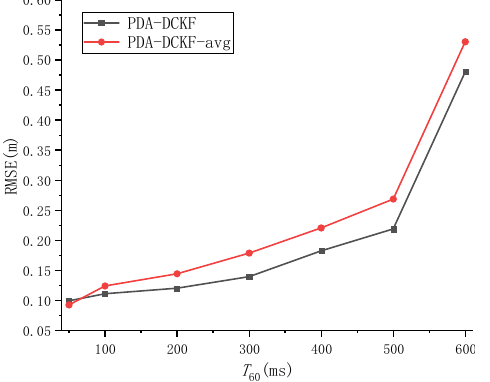
T for different fusion rules with SNR = 20 dB. Figure 8. RMSE versus T 60 for different fusion rules with SNR = 20